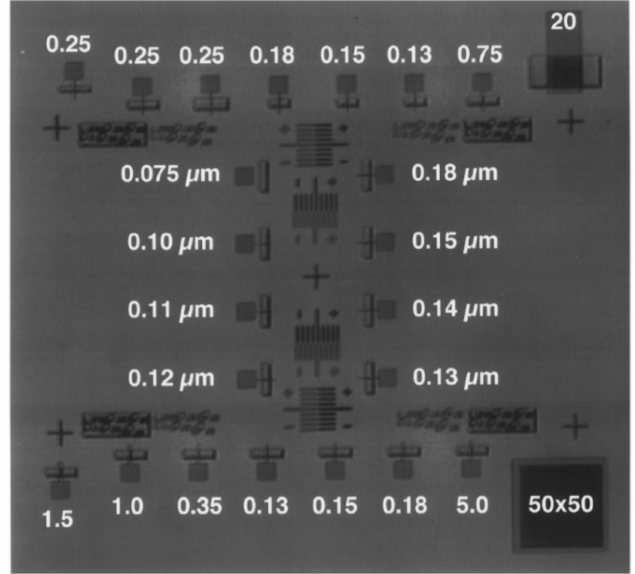
Figure 5. Configuration of NMOS device fabricated with EUVL gate-level. Reprinted with permission from [38]. Copyright 1996, American Vacuum